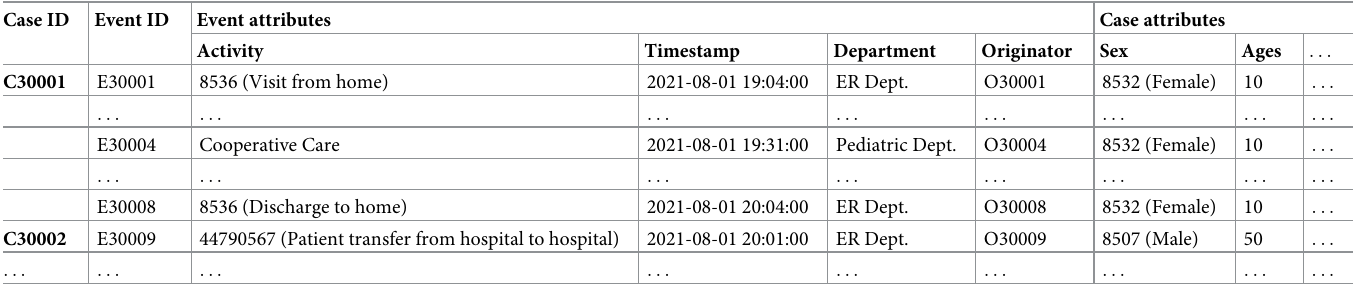
Table 4. An example of ER visit event